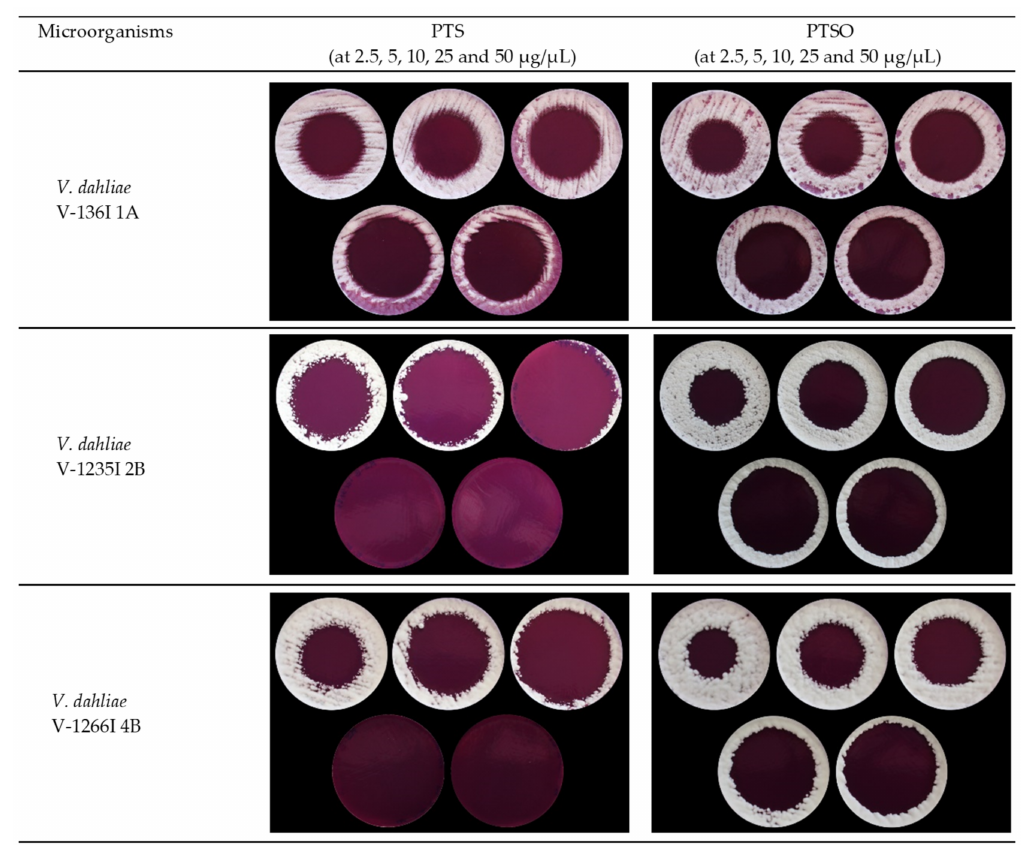
Figure 2. Antifungal activity of PTS and PTSO against Verticillium dahliae V136I 1A, V1235I 2B and V1266I 4B strains via the gas phase. The image shows inhibition zones at doses of 2.5, 5, 10, 25 and 50 µ g/ µ L from left to right and from top to